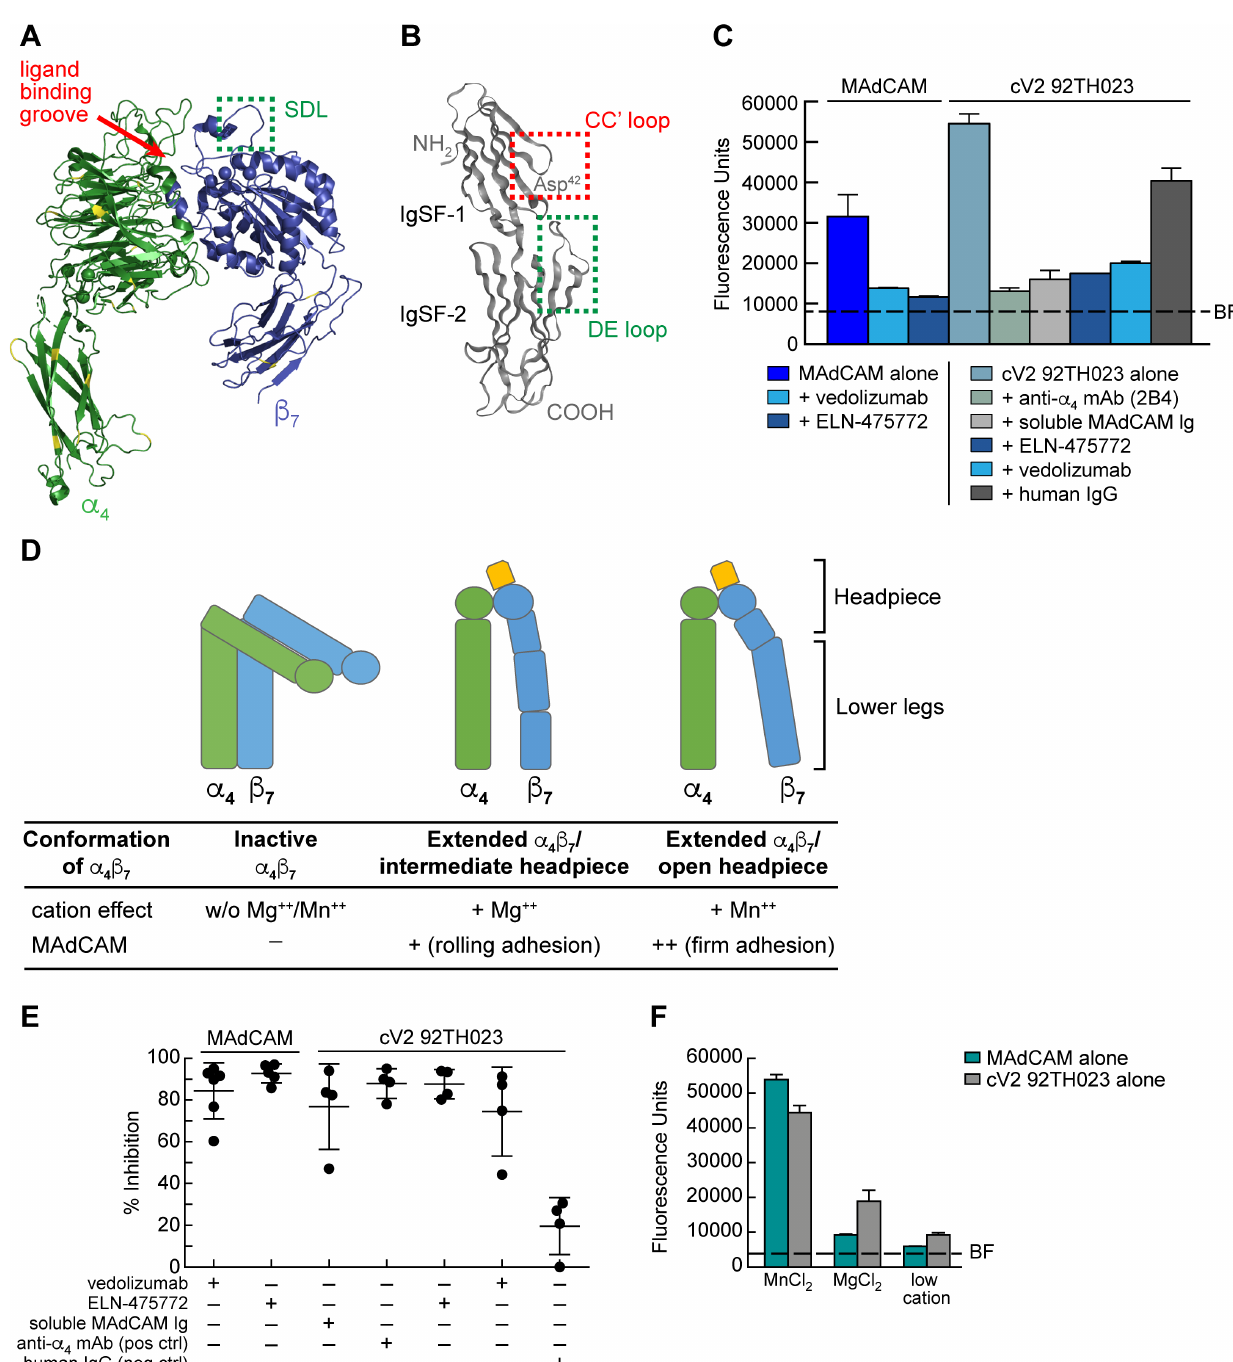
Fig 2. Inhibition of α 4 β 7 -mediated cell adhesion to MAdCAM and a cyclic V2 peptide. A) Ribbon diagram of a human α 4 β 7 heterodimer headpiece ( α 4 : green, β 7 : blue) (PDB ID: 3V4P). Yellow indicates sequence divergence in rhesus macaque. Ligand binding groove is highlighted by a red arrow, and the SDL is highlighted by a green box. B) Ribbon diagram of the two N-terminal IgSF domains of human MAdCAM (PDB ID: 1GSM). The MAdCAM CC 0 loop of IgSF domain 1 is highlighted in the red box and the DE loop of IgSF domain 2 is highlighted in a green box. C) A representative result of RPMI8866 cells adhering to immobilized MAdCAM or a cV2 92TH023 peptide in the absence or presence of vedolizumab, an LDV mimetic ELN-475772, the anti- α 4 specific mAb 2B4, soluble MAdCAM-Ig, or control human IgG, as indicated. Adhesion was determined at OD 590nm and listed as fluorescence units (y- axis). Background fluorescence (BF) of RPMI8866 cell adhesion to blank wells is denoted by a dashed line. Adhesion to immobilized MAdCAM serves as a specificity control for α 4 β 7 adhesion and human IgG is employed as a reagent control. Conditions are run in triplicate and error bars indicate standard error of the mean (SEM). D) Schematic of three conformations of the cell surface expression of the α 4 β 7 heterodimer. The influence of divalent cations